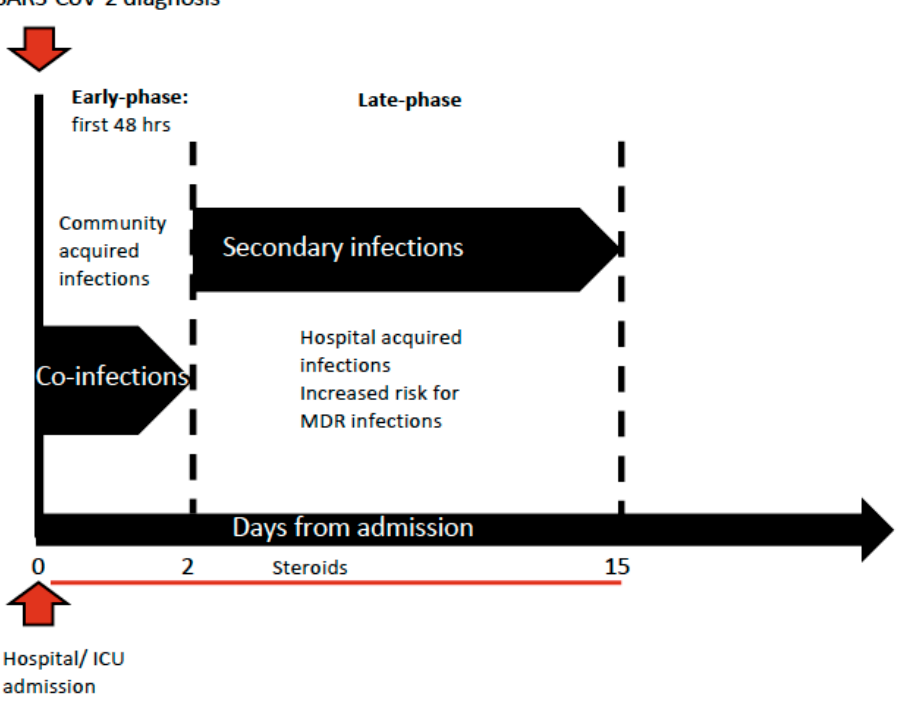
Figure 1. Timing of infections’ development during ICU stay.